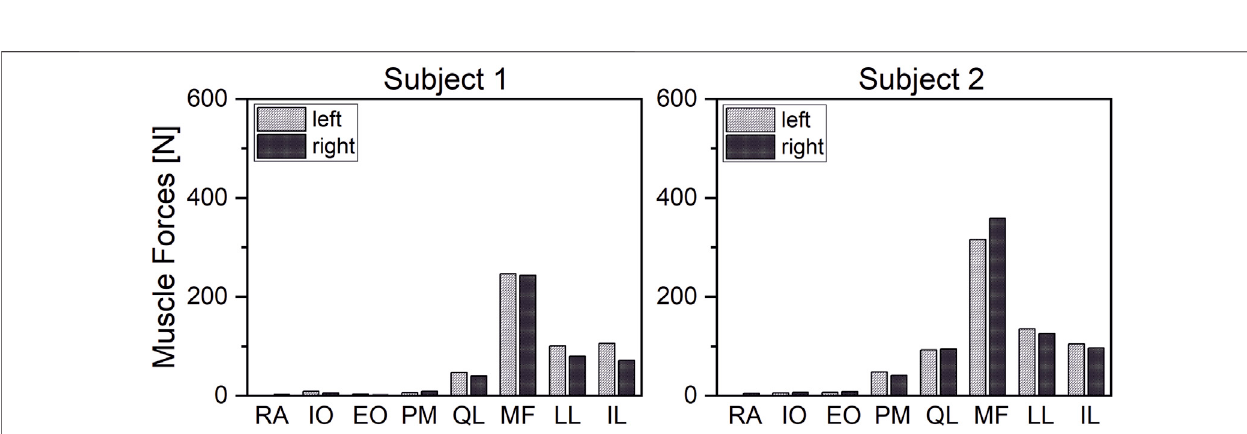
( Figure 11 ). The compensation angles for the upright standing